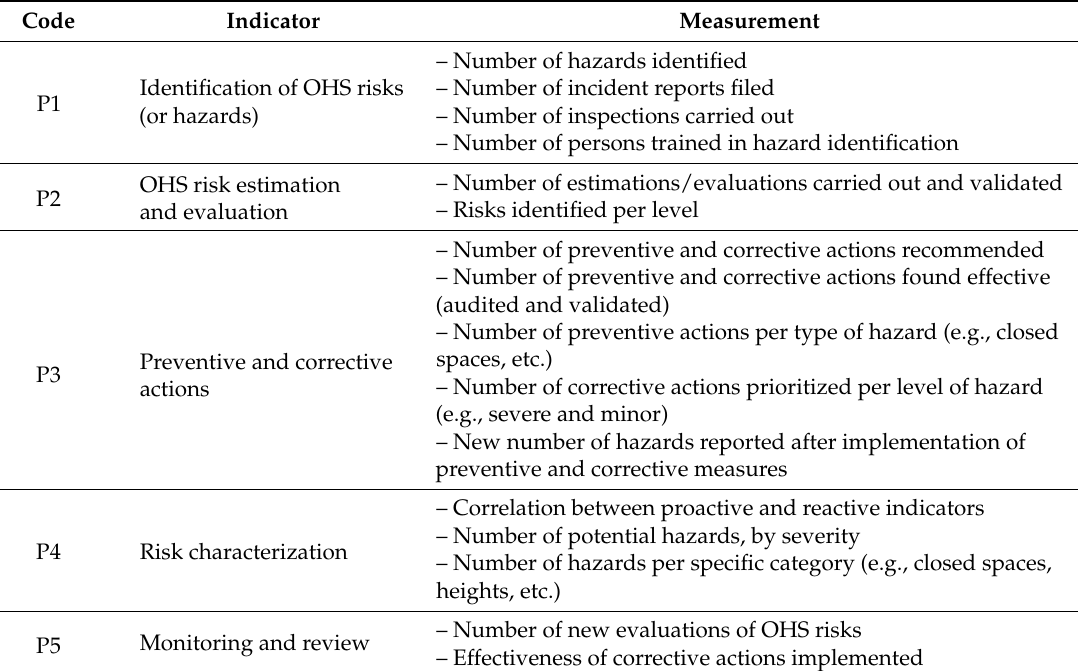
Table 2. Measurable indicators of risk management maturity based on process-based indicators.